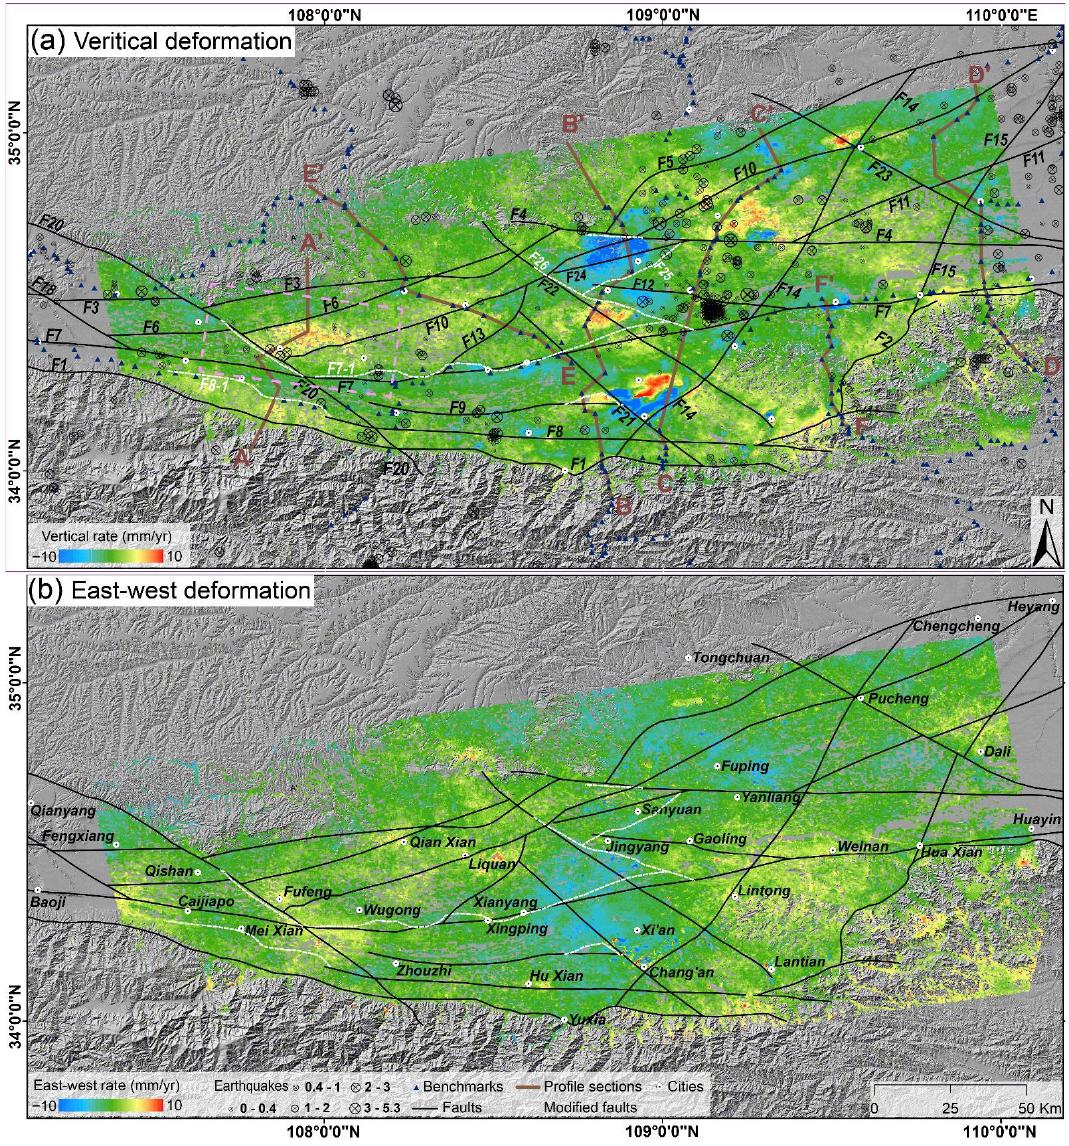
Figure 3. Two-dimensional deformation maps: ( a ) vertical deformation; ( b ) east – west deformation. Faults (black and white lines) and leveling routs (blue dots) are superimposed. The brown lines show the locations of cross-fault lines (brown lines), which are discussed in Figure 3, while the pink dashed rectangles represent locations where we conducted modeling work, as discussed in in Section